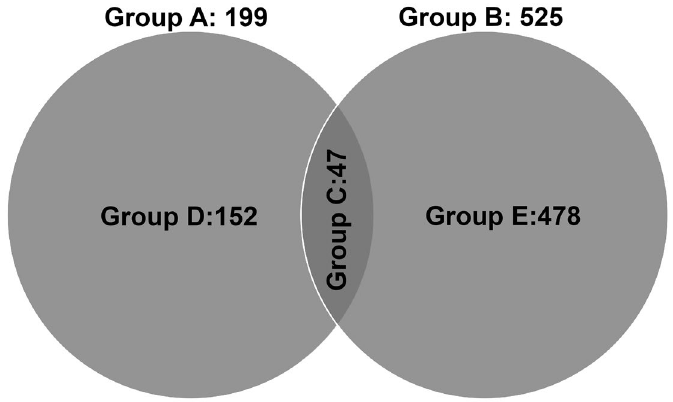
Figure 2. Venn diagram showing differentially expression groupings. DEGs of RNA seq data identified in different study groups are shown. Only genes with absolute fold change 2 and significant P value < 0.05 were included in these groupings. Group A: DEGs between DEX and ETH treated for short duration (16 h); Group B: DEGs between DEX and ETH treated for longer duration (7 d); Group C: DEGs that overlapping between Group A and Group B; Group D: Uniquely expressed DEGs of HTM cells exposed for 16 h (Group A minus Group C); Group E: Uniquely expressed DEGs of HTM cells exposed for 7 d (Group B minus Group